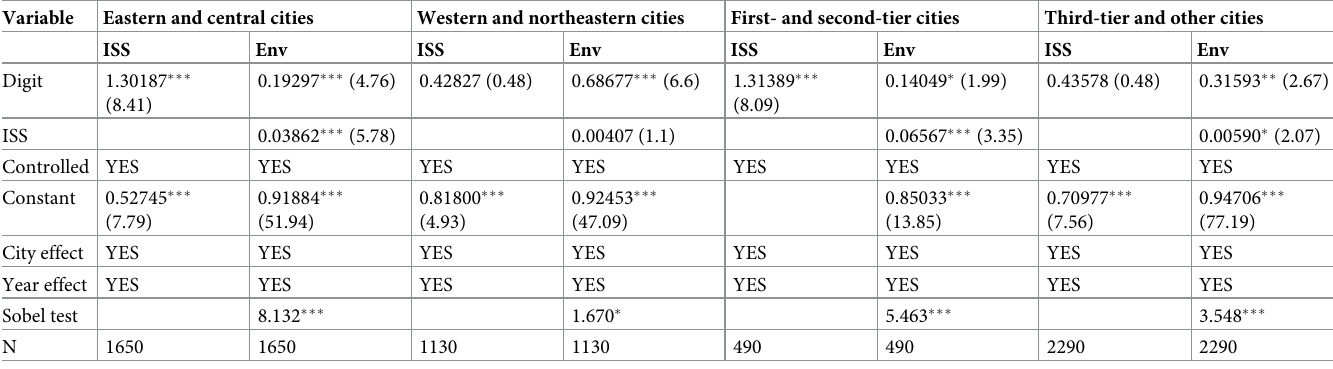
Table 8. Results of the heterogeneity of the mediating effect.